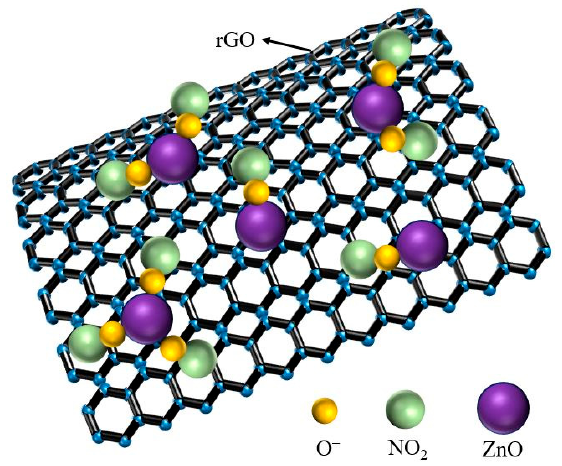
Figure 8. Schematic diagram of the gas sensing mechanism.